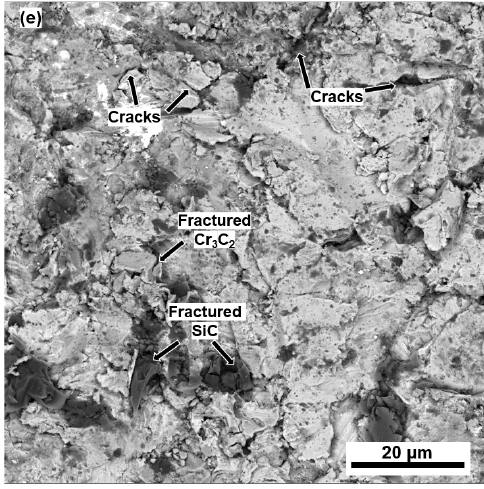
Figure 13. Eroded surface 60° angle: ( a ) C1 at RT; ( b ) at 900 °C. ( c ) C2 at RT; ( d ) at 900 °C; and ( e ) RT, backscattered electrons.